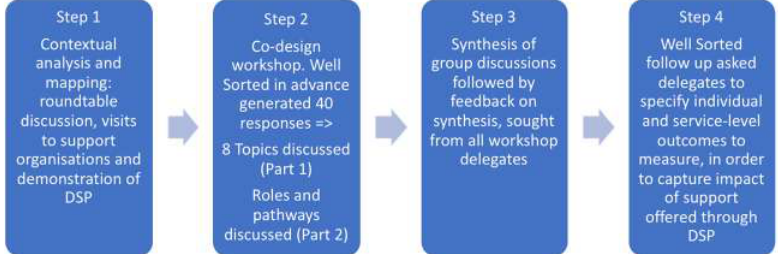
Figure 1. Methodological steps describing the co-design of a digital social prescribing intervention development workshop.